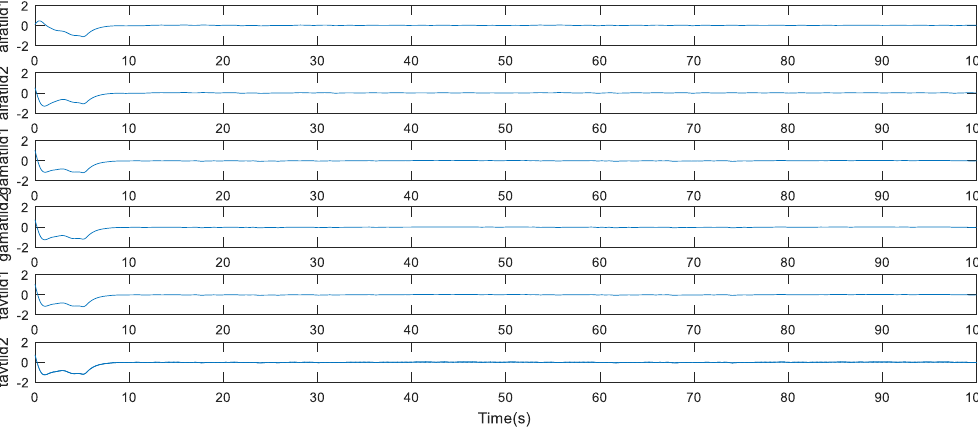
Figure 7. Estimation errors of unknown parameters in systems (25), (26) based on the proposed robust adaptive control strategy (11) where it is activated at t = 5 s, and the defined adaptation laws (12).